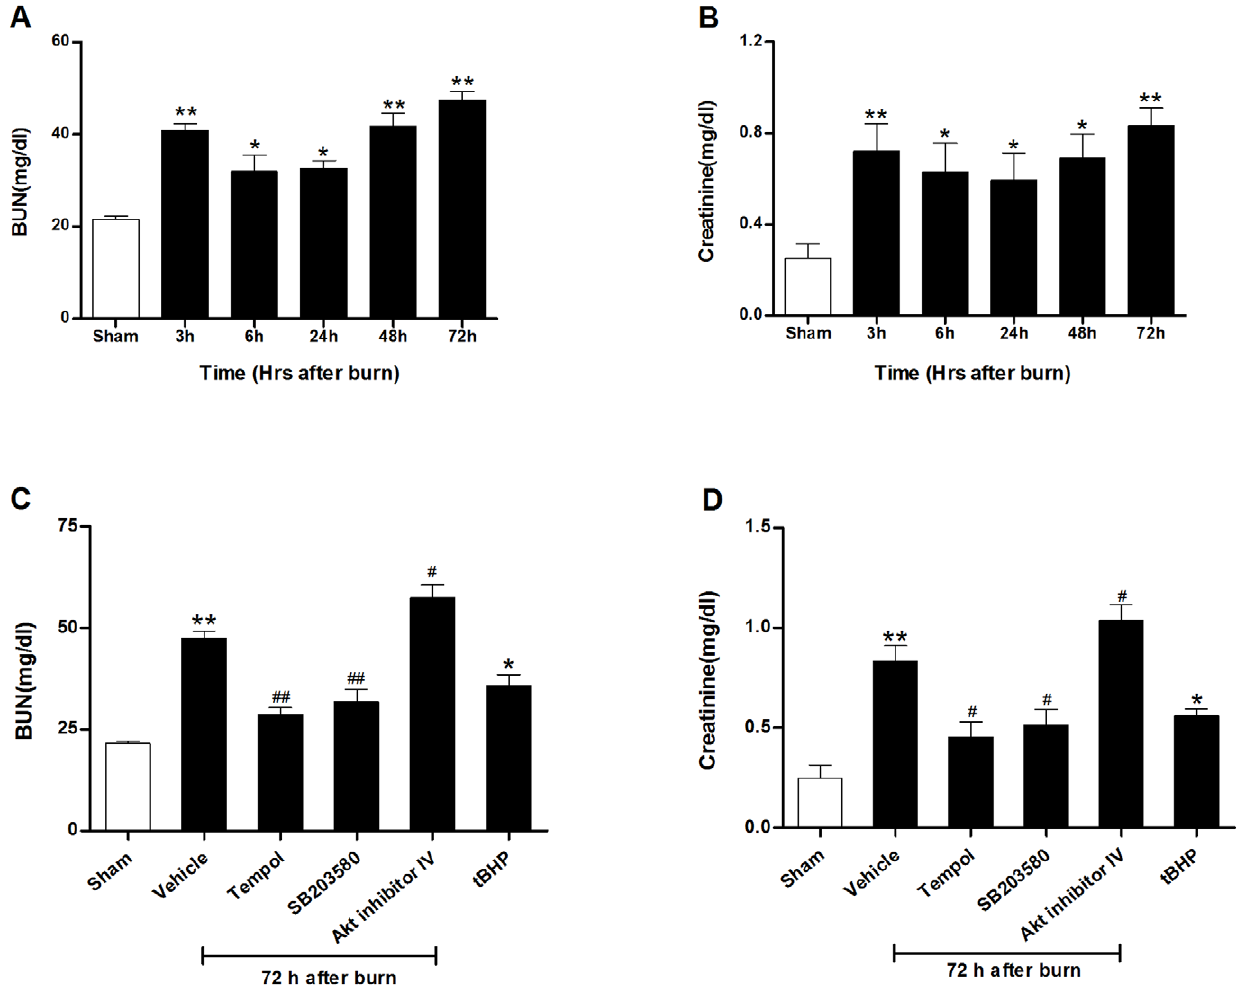
Figure 1. Blood urea nitrogen ( BUN ) and creatinine in rats after burn. Analysis of burn-induced late renal dysfunction evidenced by BUN and creatinine ( A–B ) at different time points of 3 h, 6 h, 24 h, 48 h and 72 h and ( C–D ) with different treatments at 72 h postburn. The data showed that burn induced a late renal dysfunction at 72 h, which was improved by inhibiting reactive oxygen species (ROS) or p38 MAPK with tempol or SB203580, and deteriorated by inhibiting Akt expression at 72 h. Treatment with tBHP also caused significant renal dysfunction. * P , 0.05, ** P , 0.01 vs. Sham; # P , 0.05, ## P , 0.01 vs. Vehicle. n=6 rats per group per time point.